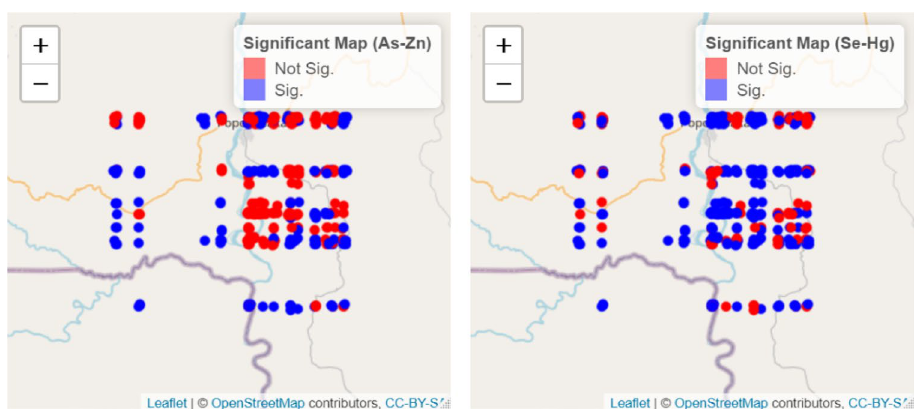
Figure 2. Local bivariate spatial association between As and Zn, and Se and Hg. Blue dots indicate a significant spatial association, and red dots indicate a nonsignificant spatial association. Geographic coordinates were systematically moved to a given direction (200 m) to avoid identifying specific households. This displacement did not affect the spatial relation of